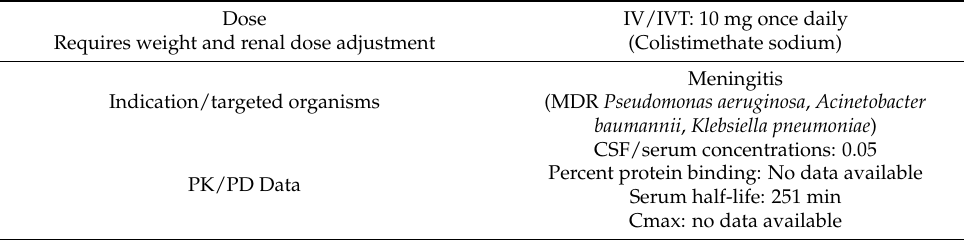
Table 10. Colistin dosing and PK/PD